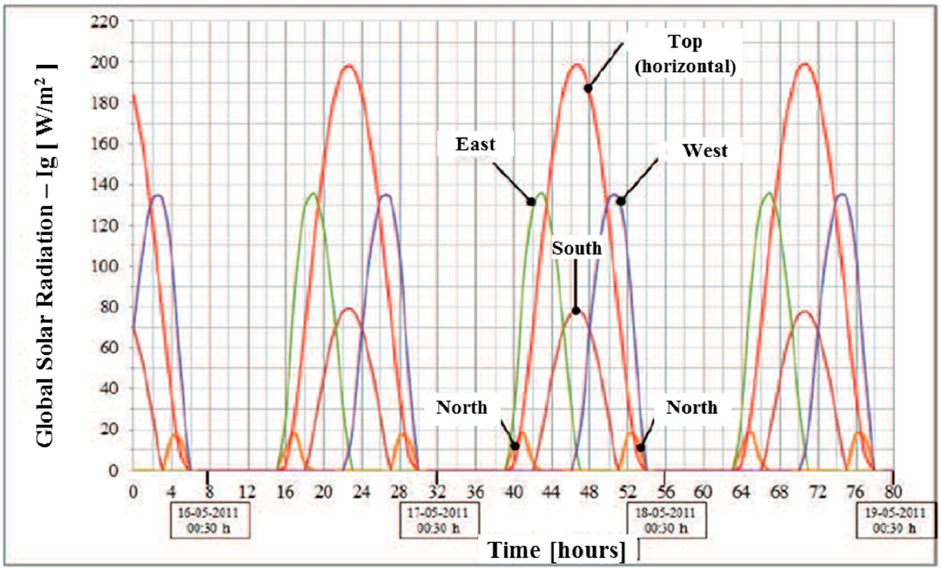
Figure 12. Absorbed radiation, by a white surface ( α s = 0.25), estimated by the solar model for T l = 4.5, between 15 and 19 May.